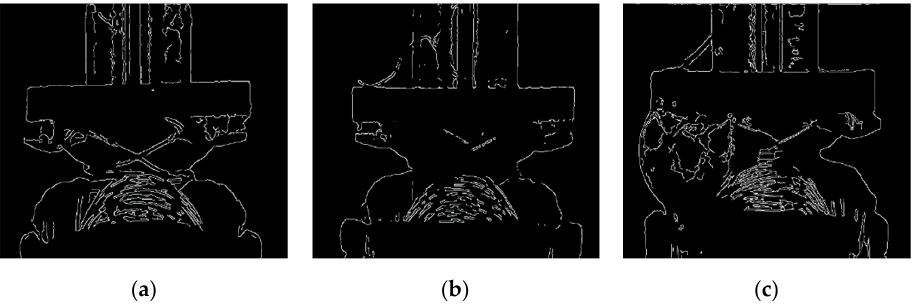
Figure 7. The edge detection results after using a bilateral filter. ( a ) shows that the picture is free of cilium and tin bags are too large defects; ( b ) reveals cilium defects. ( c ) represents the tin package is